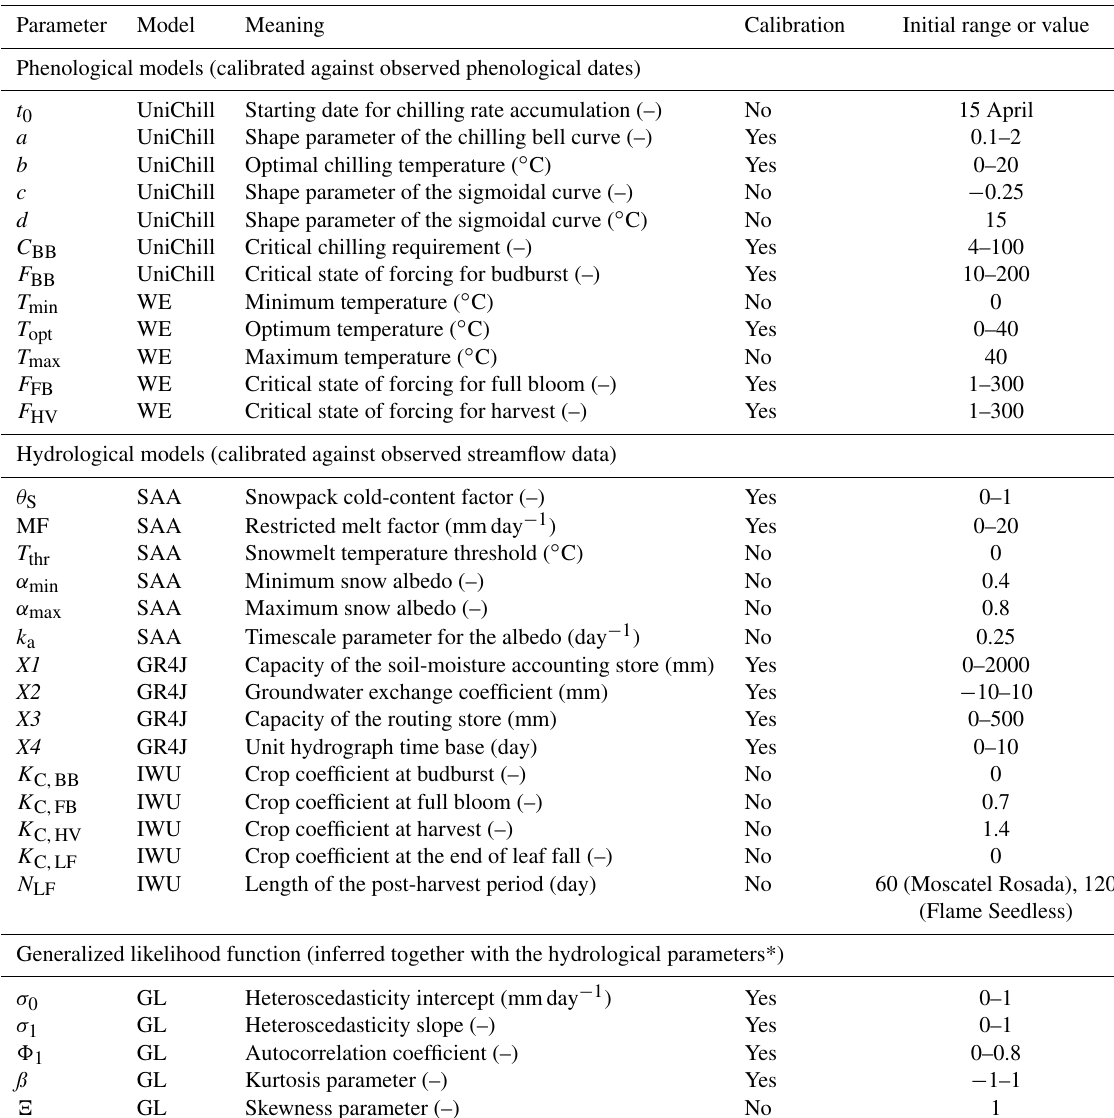
Table 1. Initial range or value of each model parameter. The third column provides explanations of the meaning of the parameters and their units (in parentheses). The fourth column indicates whether parameters are calibrated or fixed